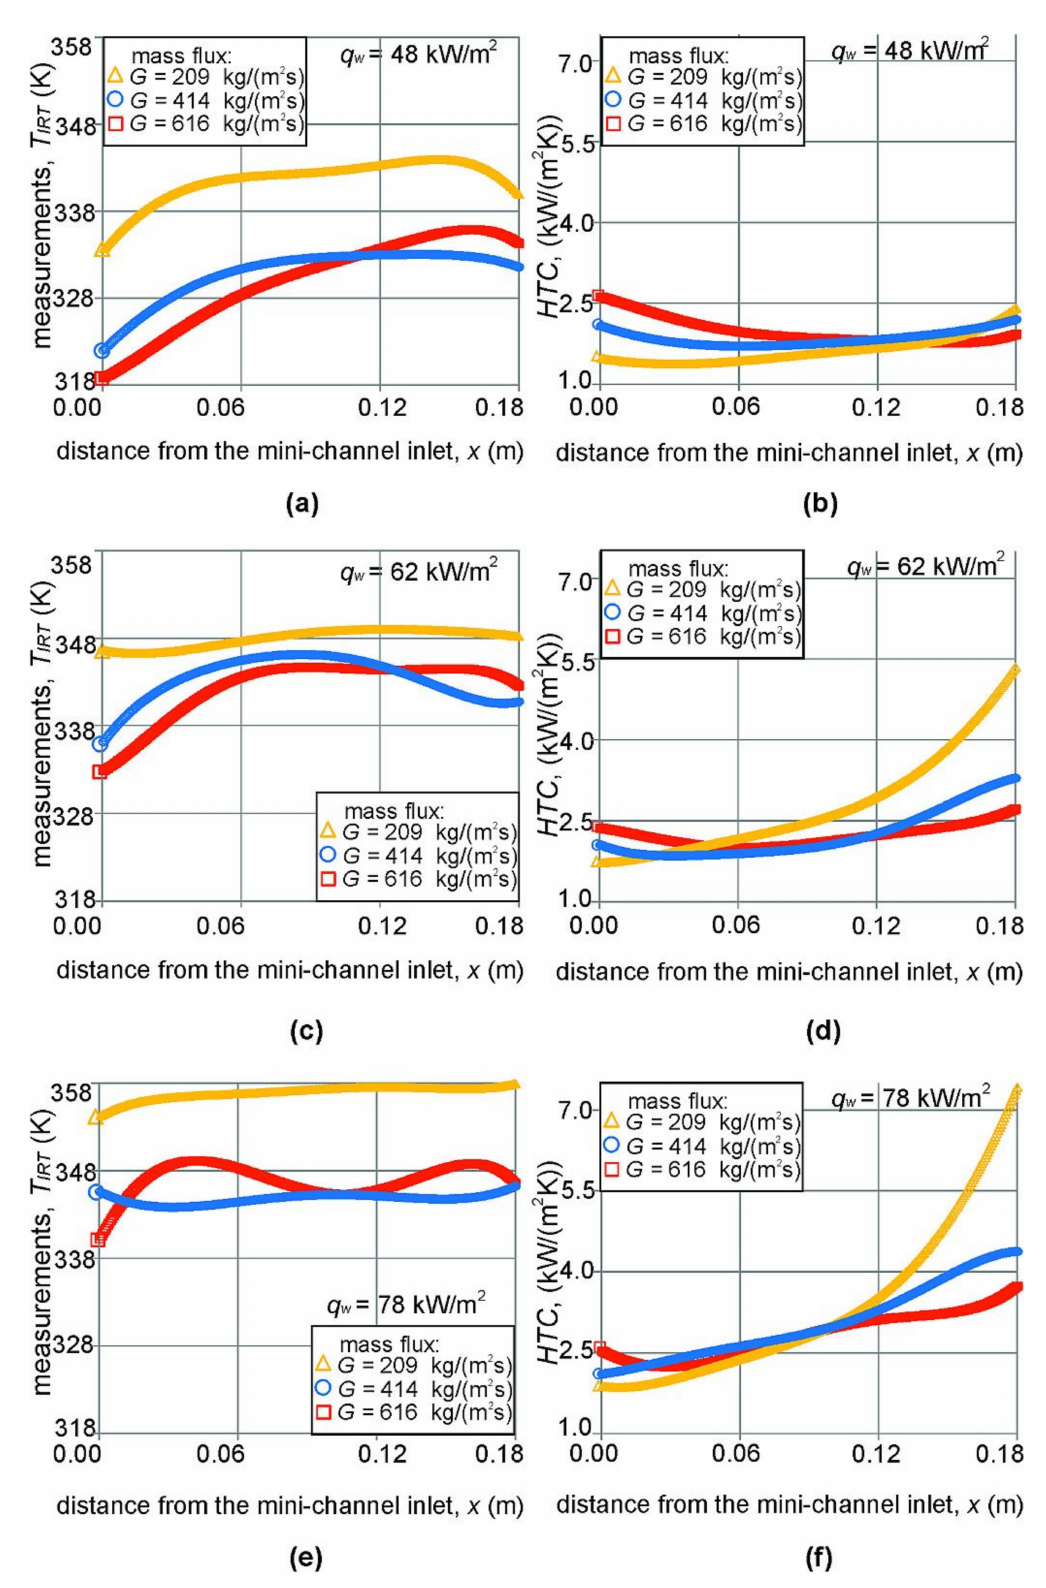
Figure 6. Plate temperature measurements using the IR camera ( a , c , e ) and heat transfer coefficient ( b , d , f ), both vs. distance from the mini-channel inlet; subcooled boiling region; various mass fluxes; vertical channel orientation (90 ◦ ); smooth heated plate; FC-72; L IRT = 180